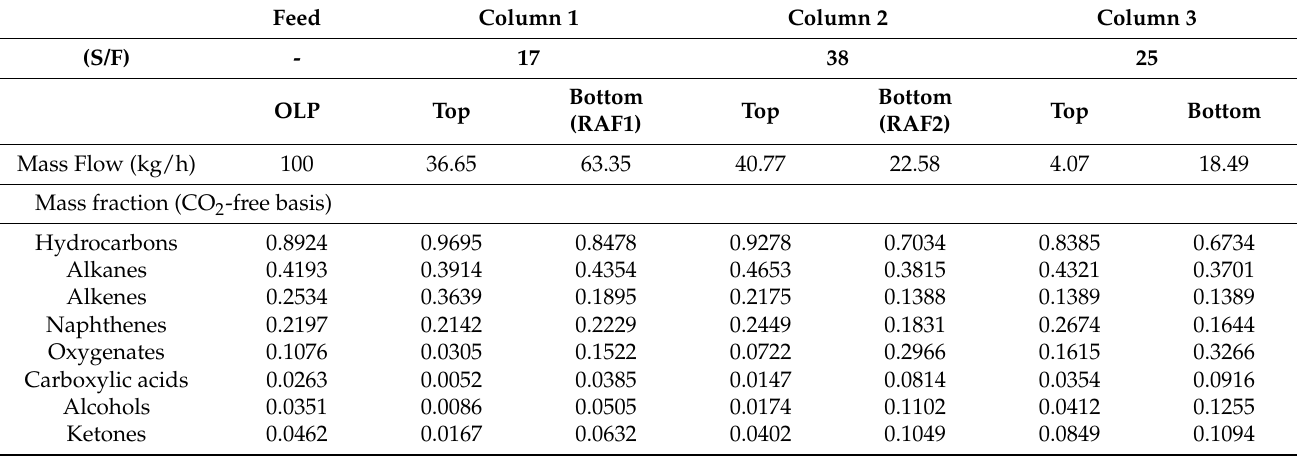
Table 3. Chemical composition, expressed on a solvent-free basis, of hydrocarbons and oxygenates of OLP in feed, top, and bottom streams of absorber columns T-100, T-102, and T-101 following the simulation of the OLP deoxygenation process in multistage countercurrent absorber columns using CO 2 as a solvent, with Aspen-HYSYS 8.6 (Aspen One, 2015) as the simulator, expressed on a CO 2 basis, at 333 K, 140 bar, and (S/F) = 17; at 350 K, 140 bar, and (S/F) = 25; and at 333 K, 140 bar, and (S/F) =